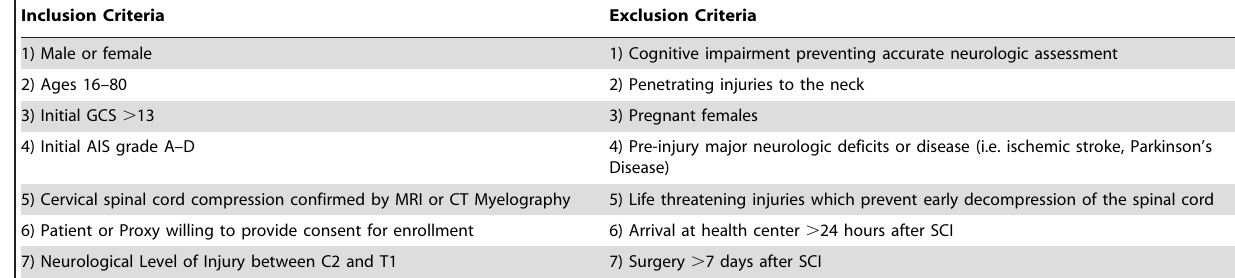
Table 1. Inclusion/Exclusion